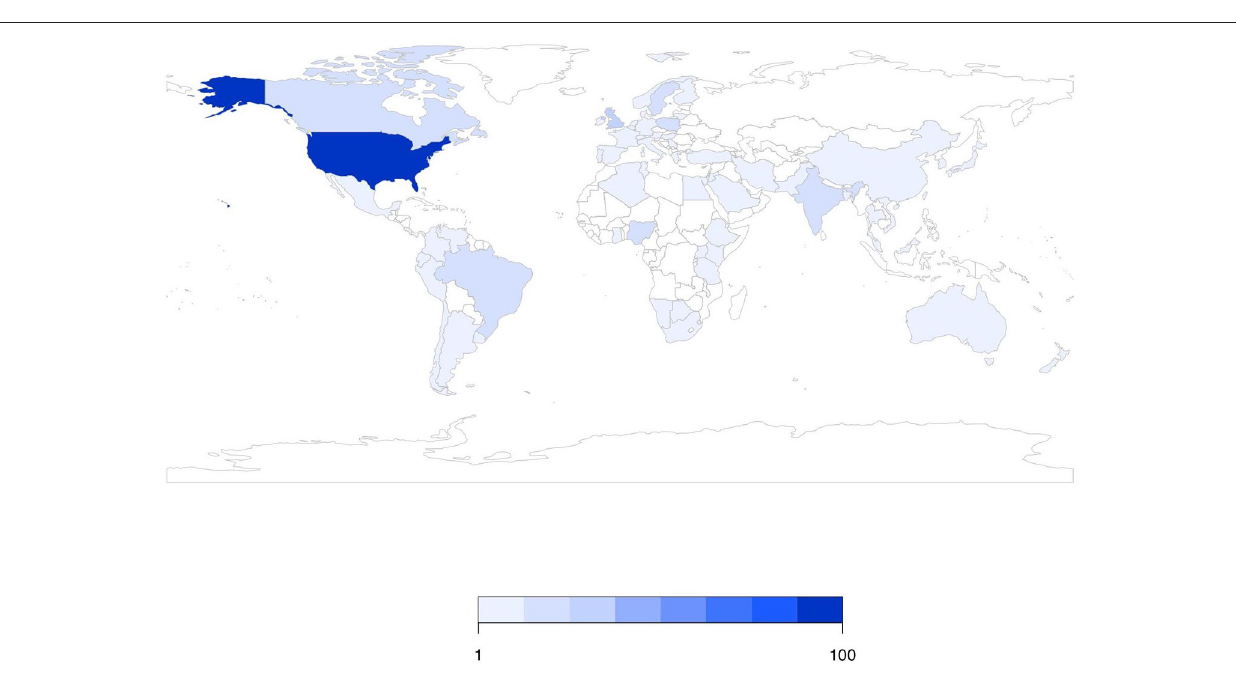
( Table 2 ). In some instances, serovars were reported as an outcome for a study but not as a study purpose;